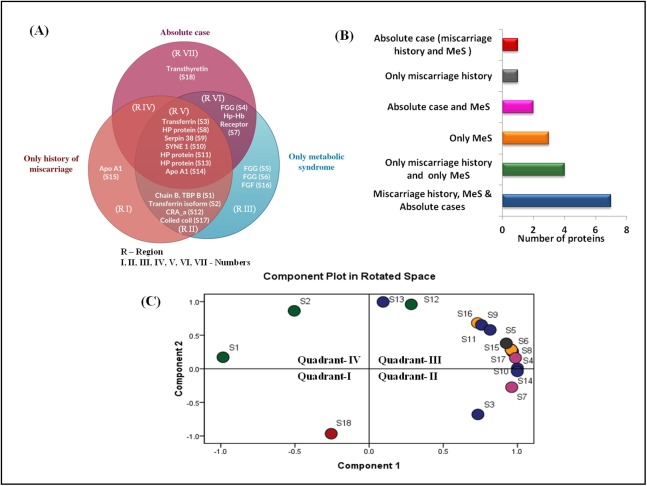
Venn diagram and PCA analysis of differentially expressed proteins.(A) Venn diagram showing the distribution of differential expressed proteins among the three case groups. Region V shows seven proteins (transferrin, three different forms of HP proteins, SYNE protein 1, serpin38, apoA1) commonly dysregulated at the intersection of three case groups; Region VII shows exclusive dysregulation of TTR in absolute cases; Region II shows four proteins (chain B transferrin binding protein, transferrin, CRA_a; coiled coil domain) commonly dysregulated at the intersection of cases with miscarriage history, and with MeS; (B) Number of differentially expressed proteins in different pathophysiological states; (C) PCA biplots based on differentially expressed proteins in all three case groups. Protein expressed in the only absolute cases was represented by a red dot in scatter plot whereas green, yellow, pink, gray, and blue dots belonged to patients having miscarriages + MeS, only MeS, absolute case + MeS, only miscarriages and all four groups, respectively.